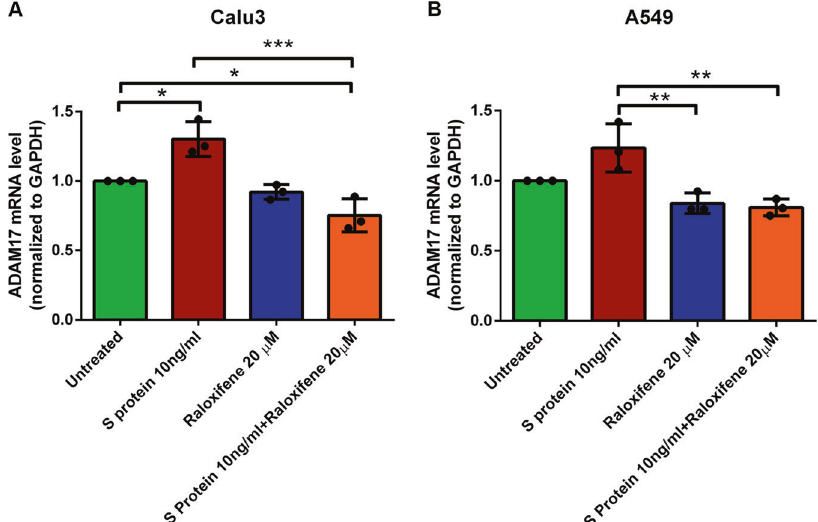
Fig. 6 Raloxifene treatment reduces ADAM17 transcriptional levels increased by S exposure. Effect of 48 hours treatment on modulation of ADAM17 mRNA in Calu-3 ( A ) and A549 ( B ) cell line treated with S protein (S 10 ng/ml), raloxifene (Raloxifene 20 μΜ ) and combined treatments (S 10 ng/ml + Raloxifene 20 μΜ ). Results are expressed as mean ± SD of 3 independent experiments. * p < 0.05, ** p < 0.01, *** P <